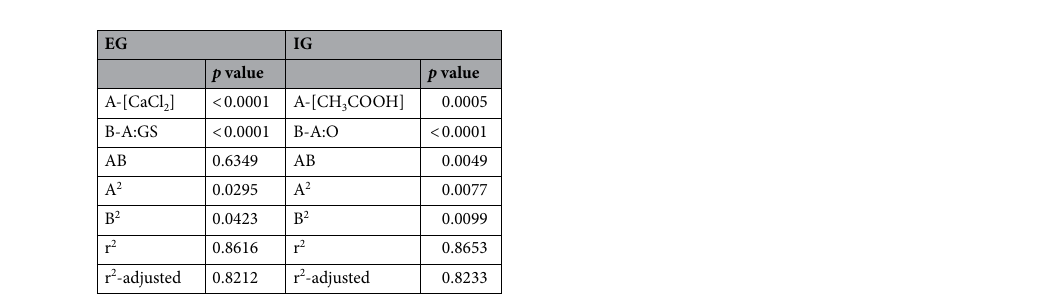
Table 2. ANOVA Table for the ionic gelation optimization process. EG external gelation, IG internal gelation,